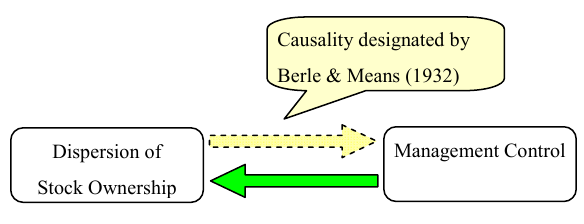
Figure 1. True causal relationship between the dispersion of stock ownership and